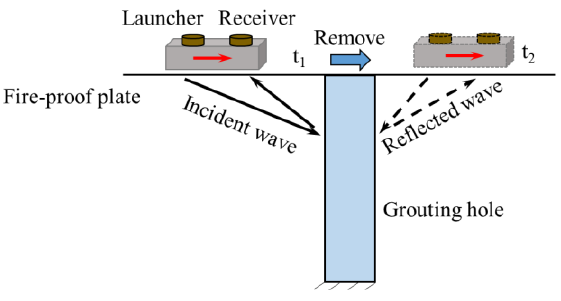
Figure 2. Scheme of nondestructive testing for a grouting hole.